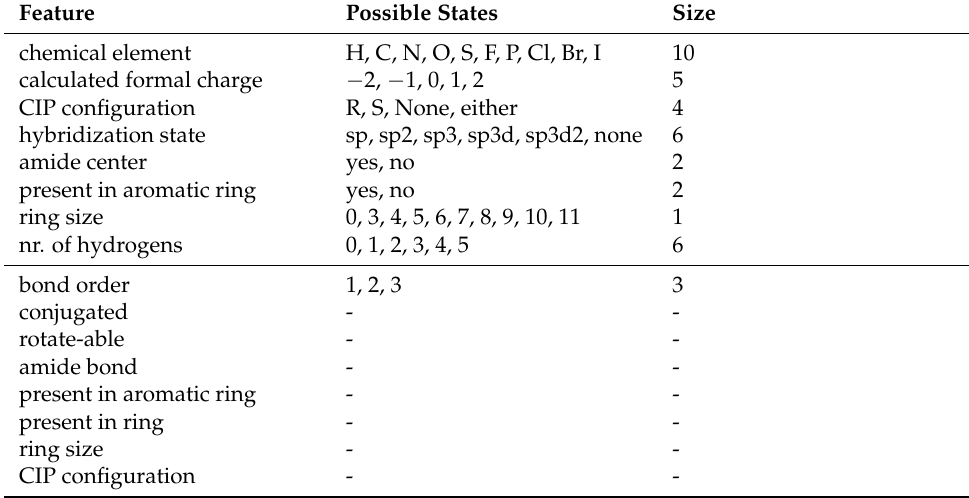
Table A5. Node and edge featurization of type 7. Each node or edge featurization vector consisted of a concatenation of the different one-hot encoded or floating point feature vectors according to their possible states (if present) and corresponding size-36 for nodes and 3 for